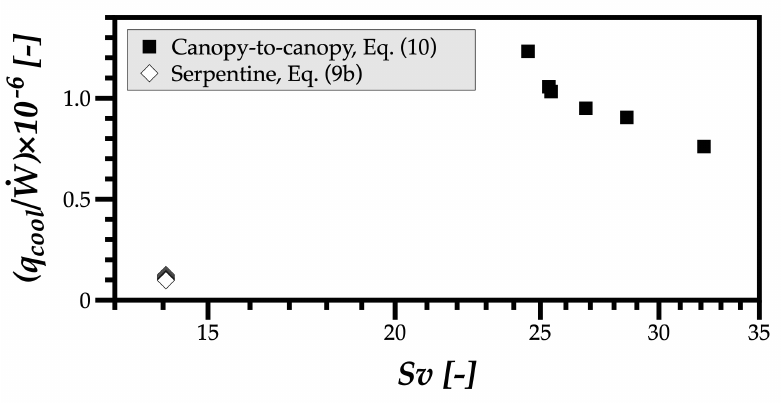
Figure 9. Relation between Svelteness for the serpentine configuration based on Equations (9b) and (10) for the canopy-to-canopy configuration with the external length scale L e based on the path length defined in Equation (12).